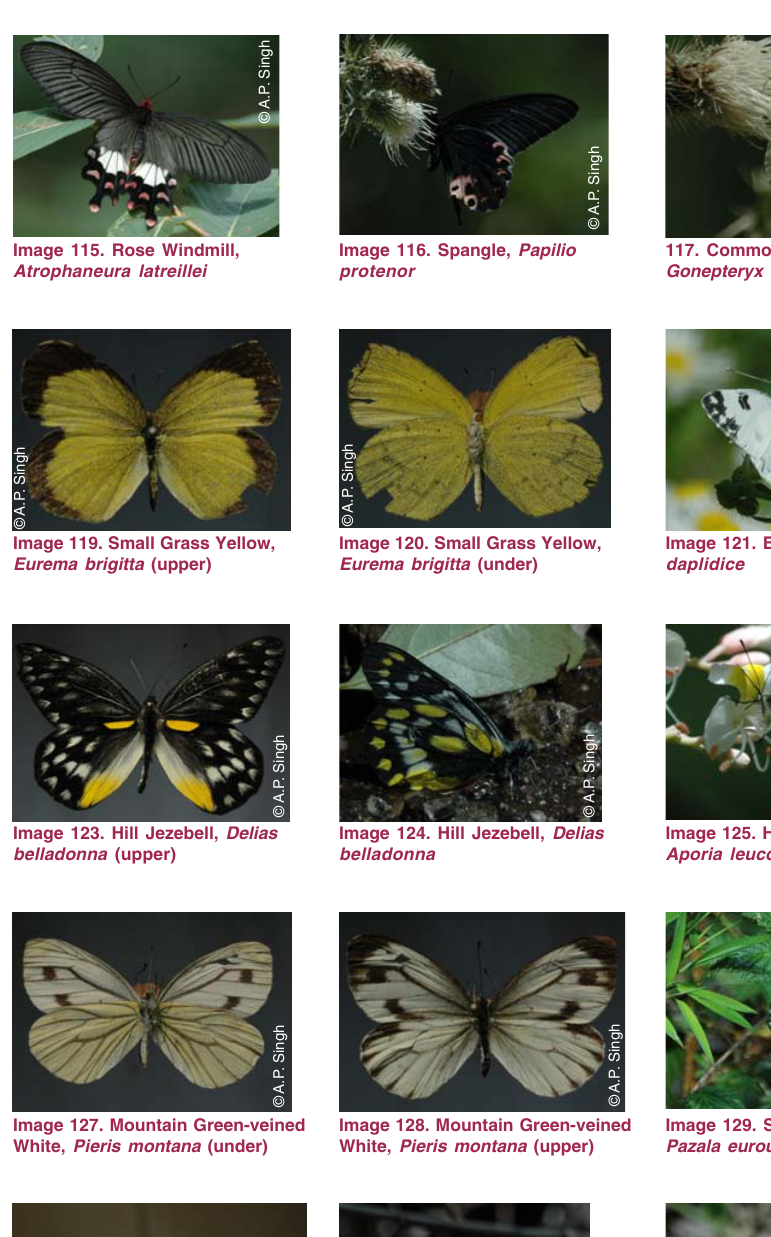
Image 129. Sixbar Swordtail, Pazala eurous (upper)